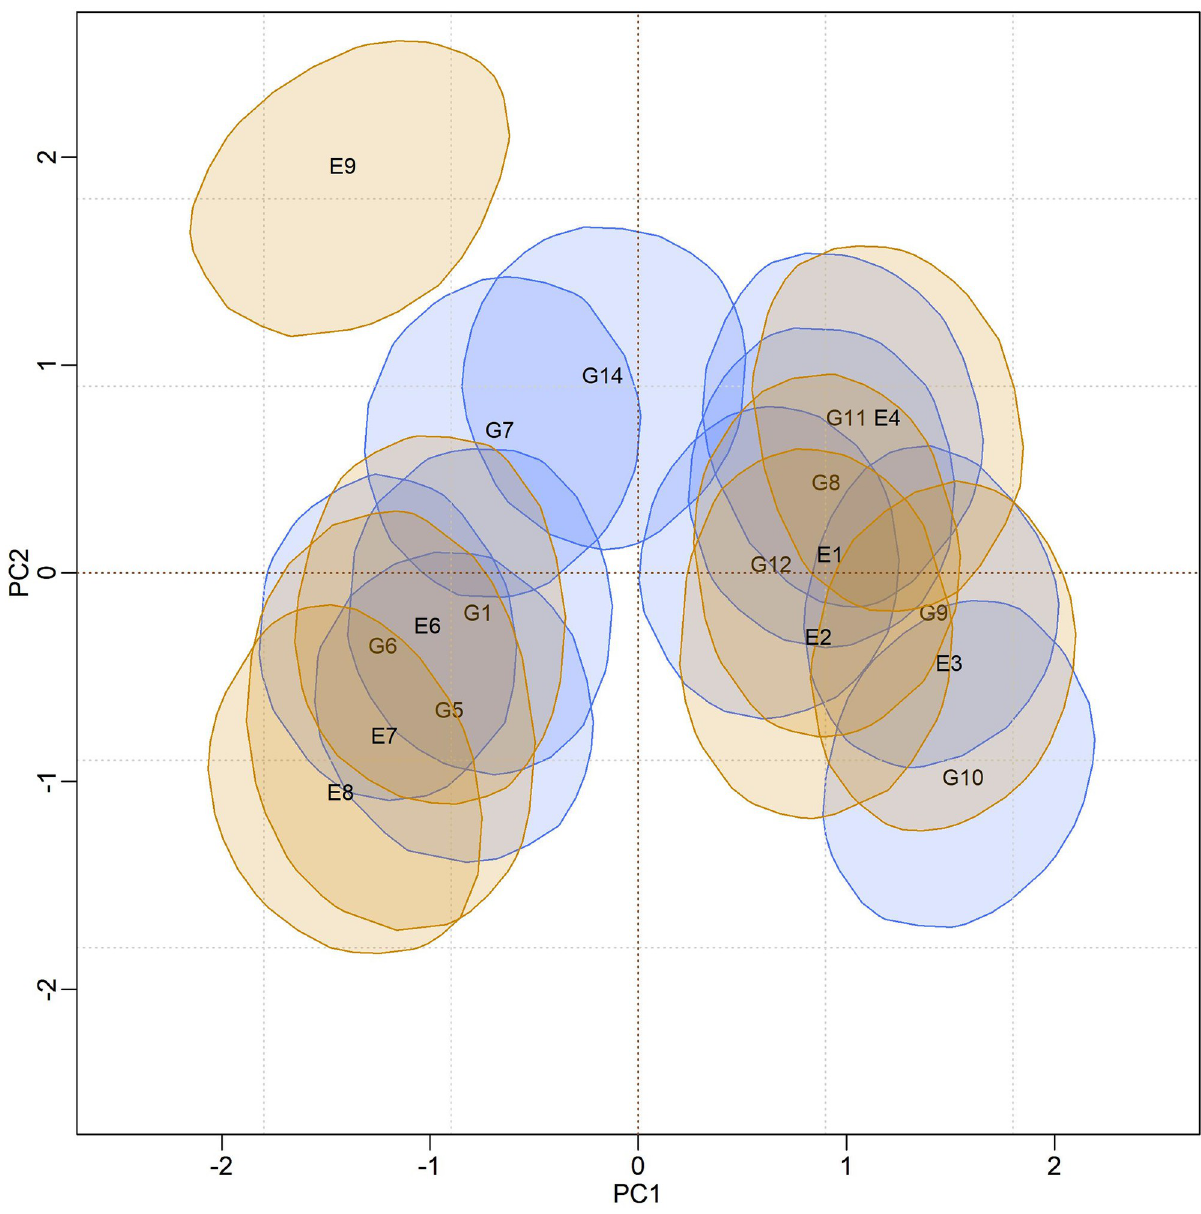
Fig 7. Bivariate credibility regions at 95% probability for the genotypic and environmental scores of the BAMMIE model whose regions do not contain the origin (0.0).